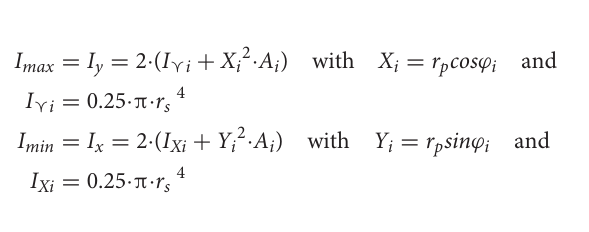
The maximum distance found for real intertwined searcher stems is typically not more than 3 times the radius of an individual stem, i.e., r p , max = 3 · r s = 3 (for normalized r s = 1). Based on these approximations the cross-sectional areas and axial second moments of area for an individual searcher